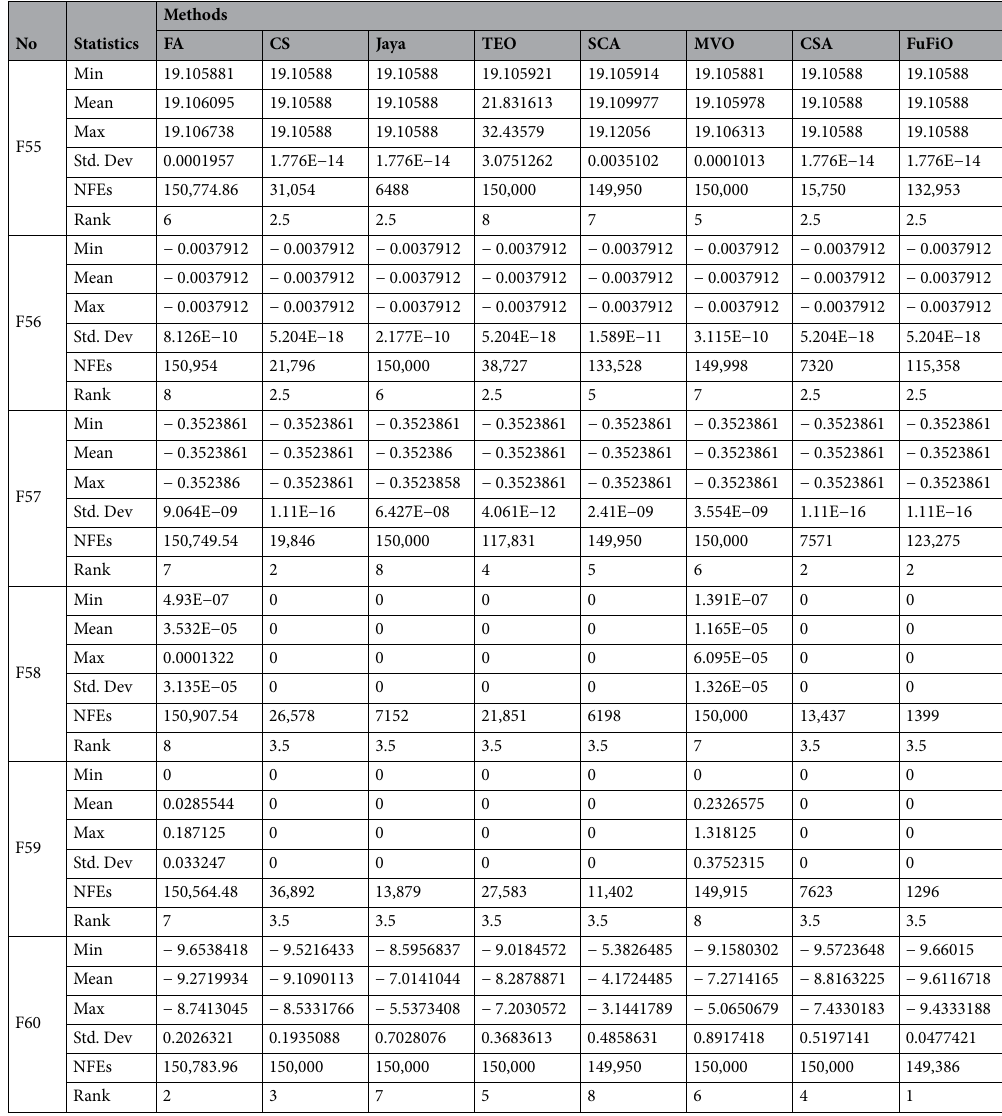
Table 5. Comparative results of algorithms for the fixed-dimensional